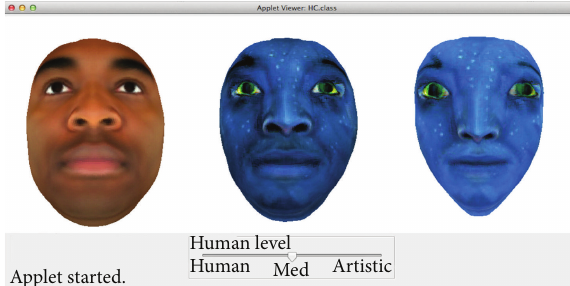
Human level Human Med Artistic Applet started. Figure 8: The runtime user interface of our approach. (Left): an input human face (HI-face), (Middle): the resultant identity- embodied artistic face with a slider to control a level of HI-face over the AS-face in the resultant face, (Right): an input artistic face (AS-